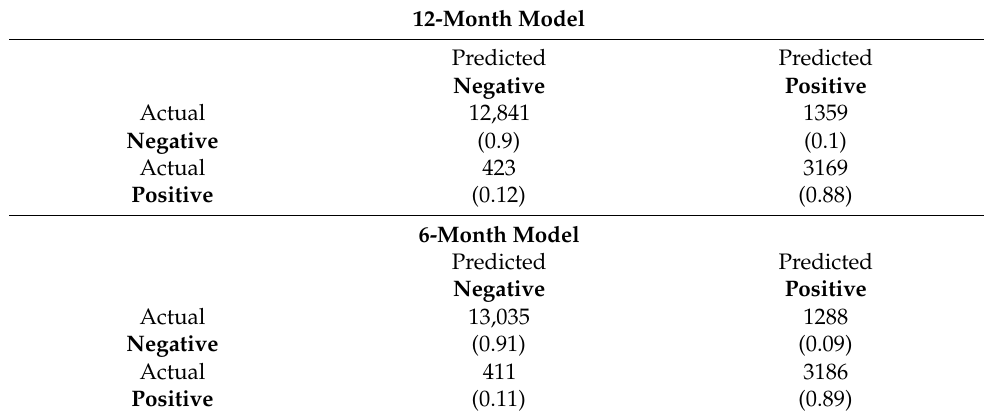
Table 2. Confusion matrices of the CNN model, showing the number of instances in each class, while the fraction of predicted instances are in parentheses.